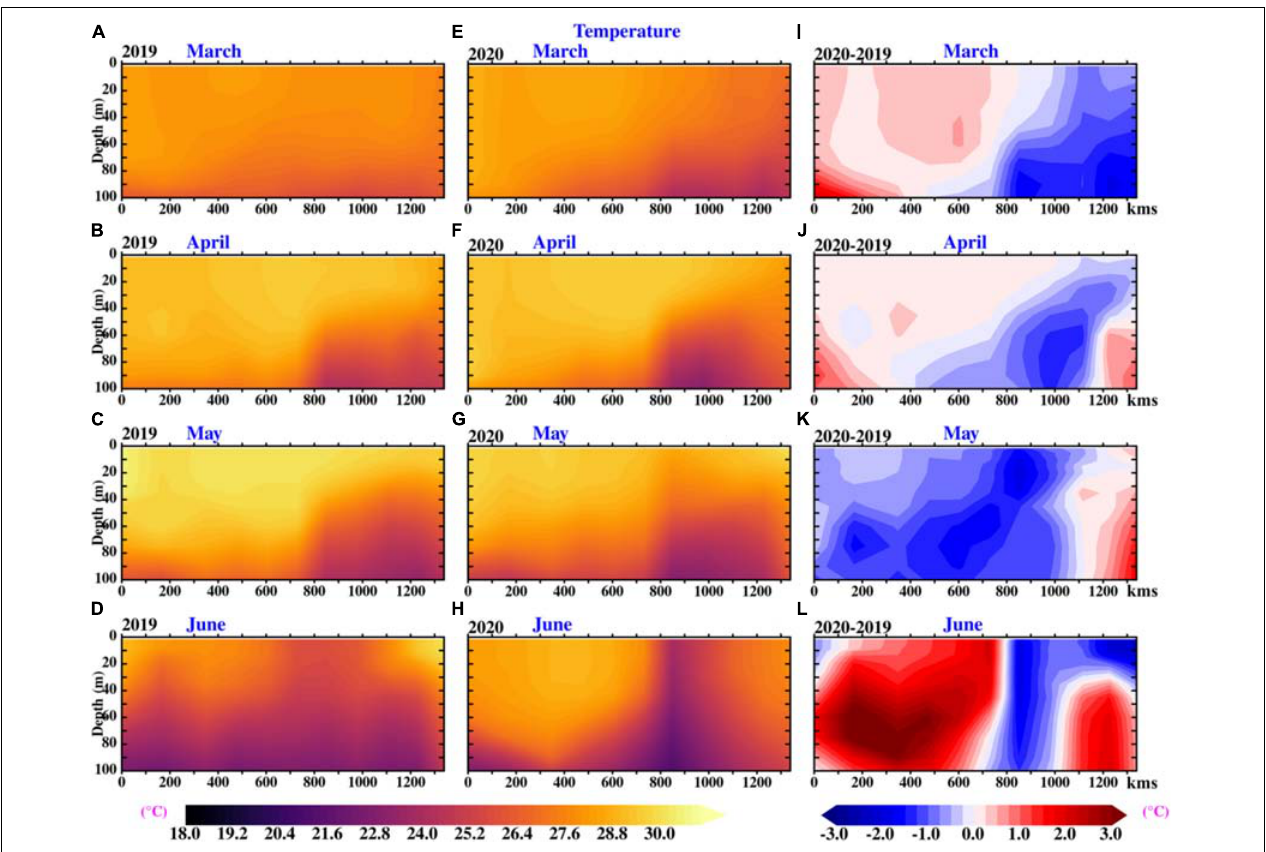
FIGURE 16 | Evolution of model-simulated temperature along the 1,000 m isobath off Somalia coast (as shown in Figure 1 ), (A–D) during the pre-pandemic period (March–June 2019), (E–H) pandemic period (March–June, 2020), and (I–L) difference in temperature (2020–2019) for respected months from March to